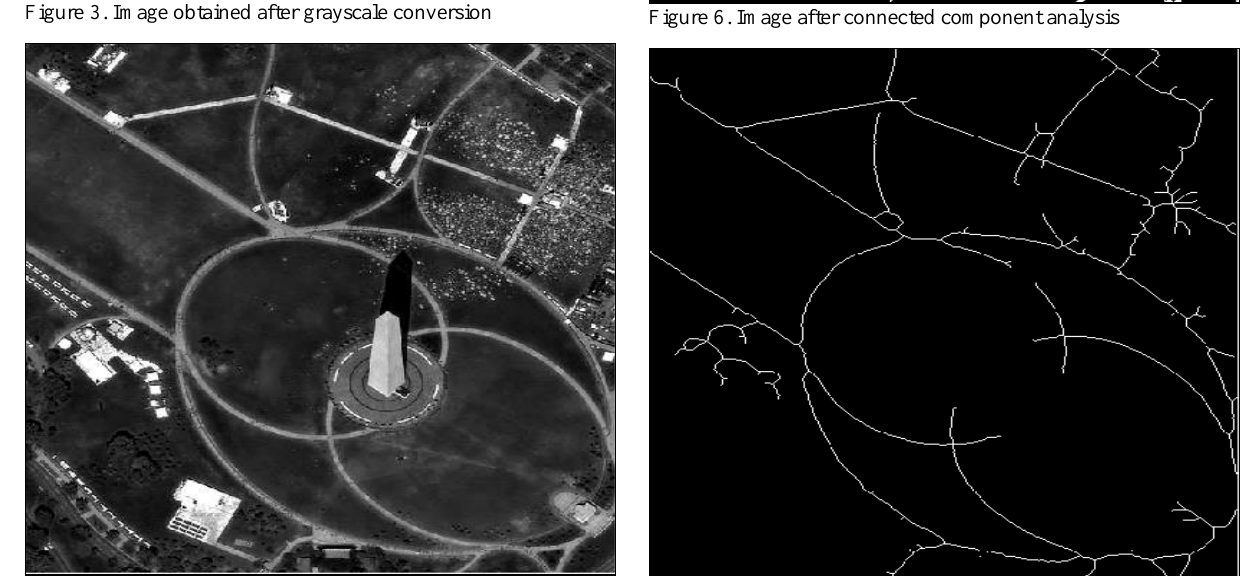
Figure 7. Image obtained after applying